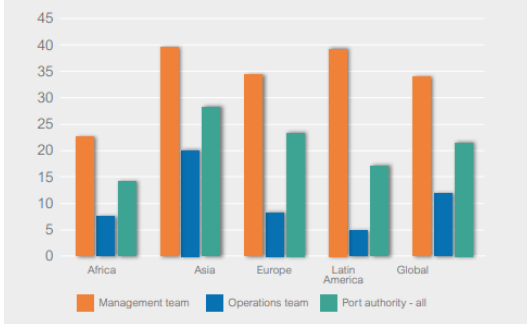
Figure 1. The Ratio of Women Participation in